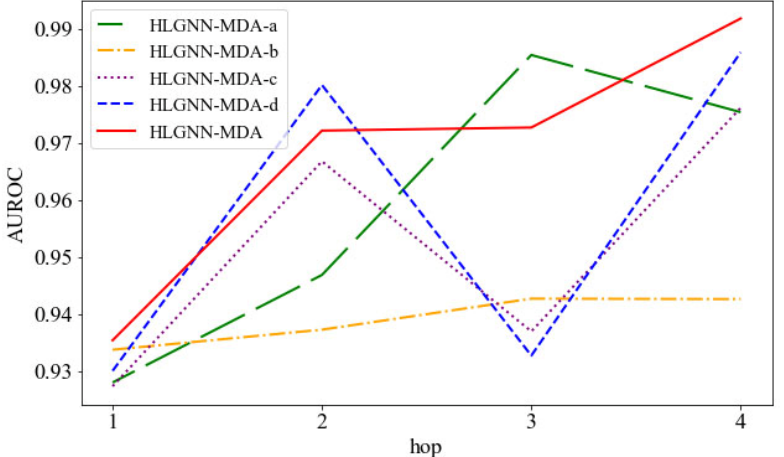
Figure 9. AUC comparison between HLGNN-MDA and its four variations under different hops. Furthermore, since the graph neural network [55,56] of HLGNN-MDA is improved with respect to DGCNN, in order to show the effectiveness of HLGNN-MDA model, we also compared the performance of four variants of HLGNN-MDA with DGCNN with different hops. From Table 3, it could be concluded that DGCNN and HLGNN-MDA- b performed similarly. HLGNN-MDA-b was slightly higher than DGCNN when the enclosing subgraph hops were 1, 2 and 3. Compared with other HLGNN-MDA variant models, HLGNN-MDA-b, i.e., the A 2 -deleted model, had the worst performance among all models. As the value of hops increased, the six measures of HLGNN-MDA-b also increased slowly, and when hop = 3, HLGNN-MDA-b reached a maximum. This finding was consistent with the results presented in the above figures; that is, A 2 played a large role in the HLGNN-MDA model. Overall, HLGNN-MDA performed better than DGCNN in predicting miRNA–disease